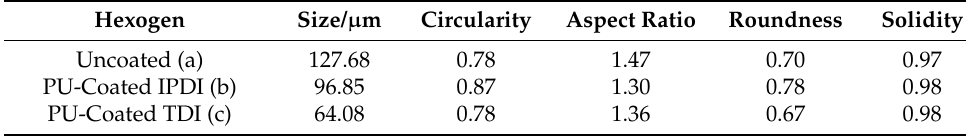
Table 1. Comparison between uncoated and coated hexogen